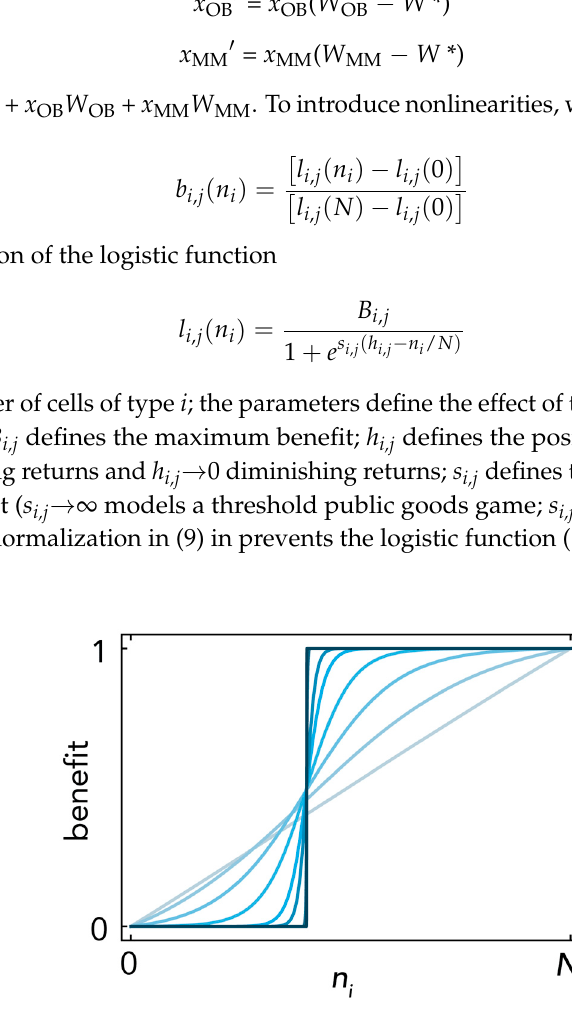
Figure 10. Sigmoid benefits. The benefit of the growth factors produced by type i on type j is described as a normalized logistic function (of the number n i of cells of type i ), with inflection point h i,j ; here h i,j = 0.4; B i,j =1. Multiple curves are shown, with increasing steepness s i,j (increasing opacity) from s i,j → 0 (linear benefits) to s i,j → ∞ (a step function).